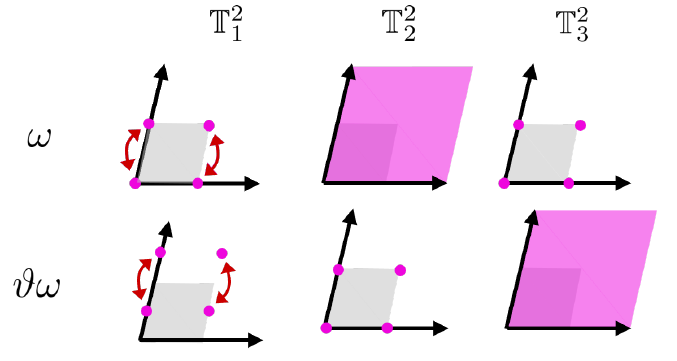
Figure 14 . An illustration of the fixed points (pink) in the Z 2 × Z 2 − 1 − 2 orbifold.